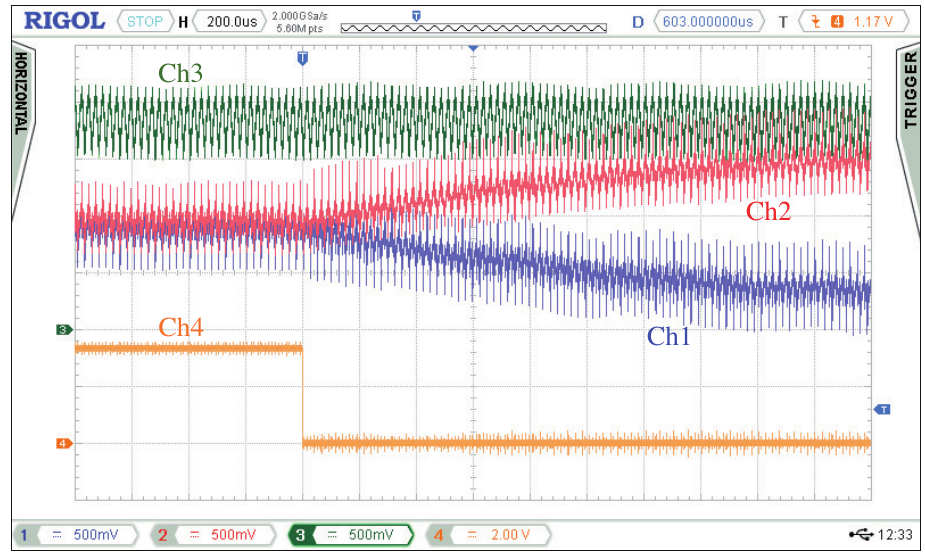
Figure 17. Transient response against a current reference i ∗ current (2 A/div). Ch2: PV voltage (10 V/div). CH4: current reference synchronism digital output.